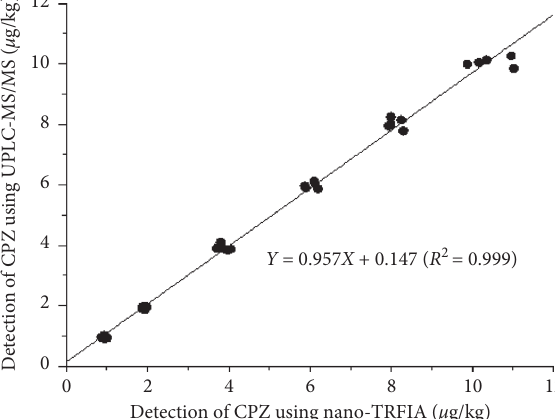
Figure 5: Correlation analysis of nanosphere-based time-resolved fluorescence immunoassay (nano-TRFIA) and ultraperformance liquid chromatography-tandem mass spectrometry (UPLC-MS/MS) results (six negative minced pork samples were added to chlorpromazine (CPZ) standard solutions at 1.0, 2.0, 4.0, 6.0, 8.0, and 10.0 μ g/kg). The x -axis is the detection result of CPZ using nano-TRFIA; the y -axis is the detection result of CPZ using UPLC-MS/MS. Table 4: Comparison of nano-TRFIA and UPLC-MS/MS for CPZ detection in real pork samples ( n � 5).